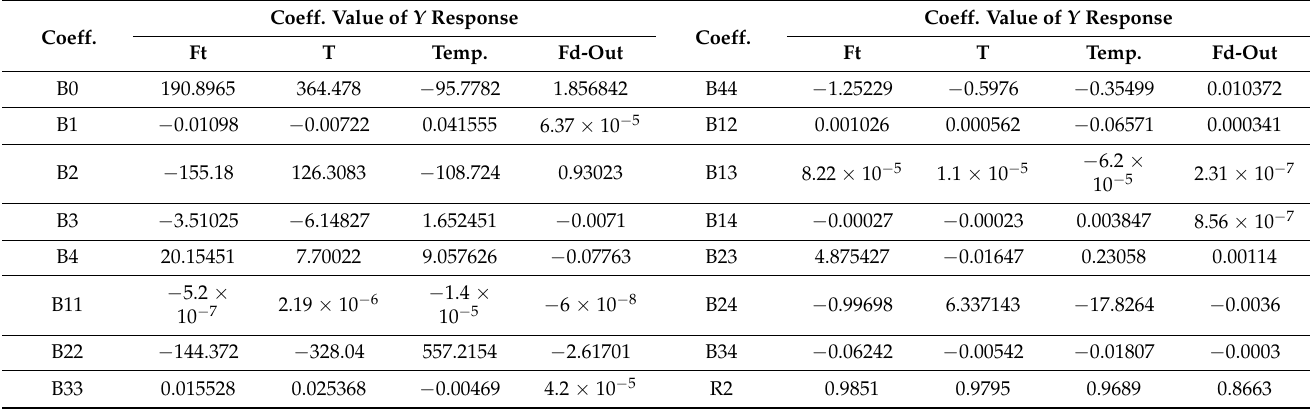
Table 10. Quadratic regression model for machinability